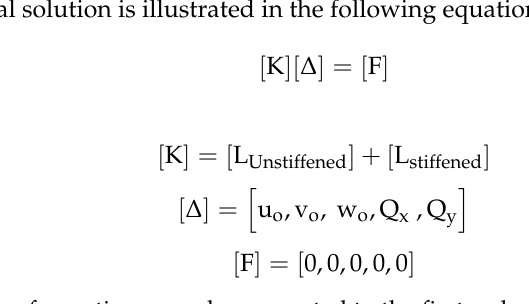
Figure 2. Stiffened plate with different stiffeners along x and y directions.